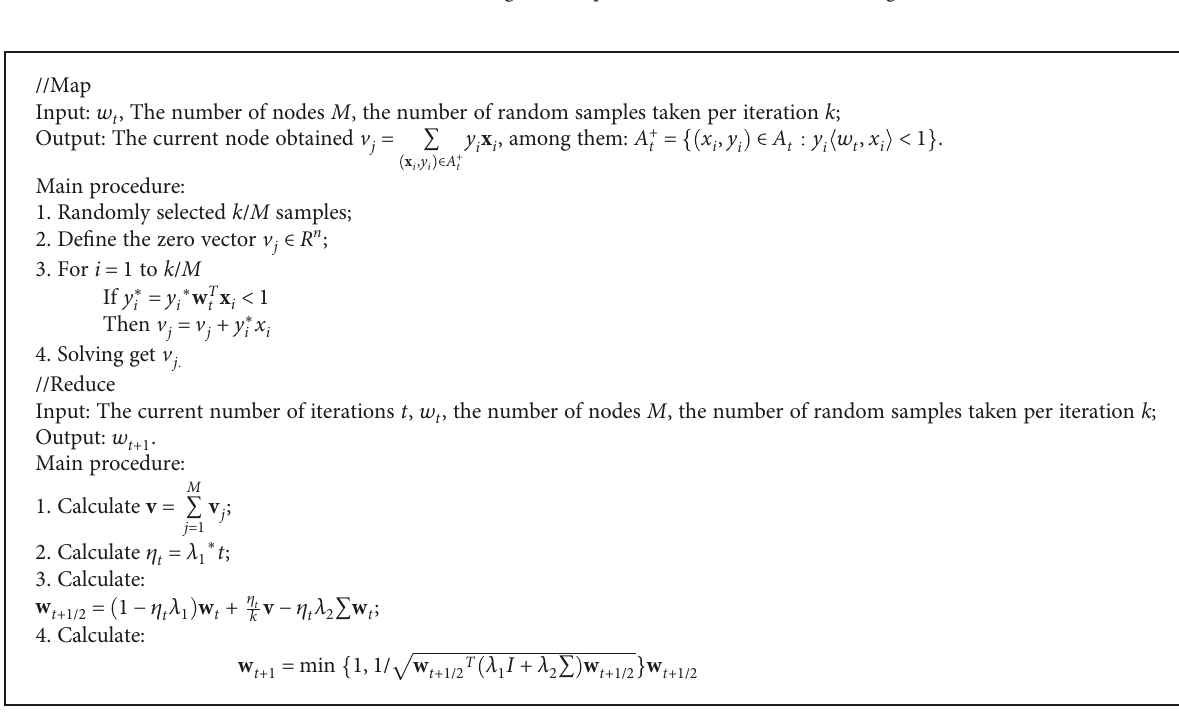
Algorithm 3: Parallel design of sample covariance matrix for training set.